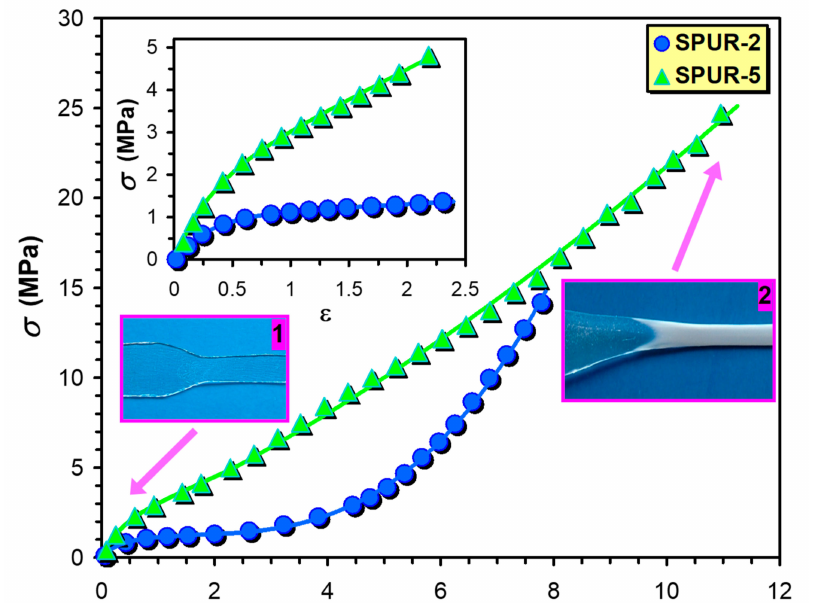
Figure 7. The stress-strain ( σ - ε ) curves for the samples SPUR-5 and SPUR-2. The symbols and the solid lines stand for the experimental data and the fitted curves, respectively. The inset figure reveals the lower part of the σ − ε curves up to ε = 2.2. The pictures illustrate the dumbbell from sample SPUR-5 at low (1) and at high strain (2). The fitted parameters for the sample SPUR-5 are b 1 = 1.41 MPa, b 2 = 1.18 and b3 = 3.24 (i.e., [(d ε / dt)a 1 ] − 1 = 3.24, a 2 = 1.41 MPa, (d ε / dt)a 3 = 2.10 MPa and α = 0.136 MPa and β = 0.75), while for the sample SPUR-2 these parameters are b i.e., [(d ε / dt)a 1 ] − 1 = 3.15, a 2 = 0.12 MPa, (d ε / dt)a 3 = 1.09 MPa and α = 0.084 MPa and β = 1.75). (The stress-strain ( σ - ε ) curves for the samples SPUR-1, SPUR-3 and SPUR-4 are shown in Figures S1–S3, respectively in the Supplementary